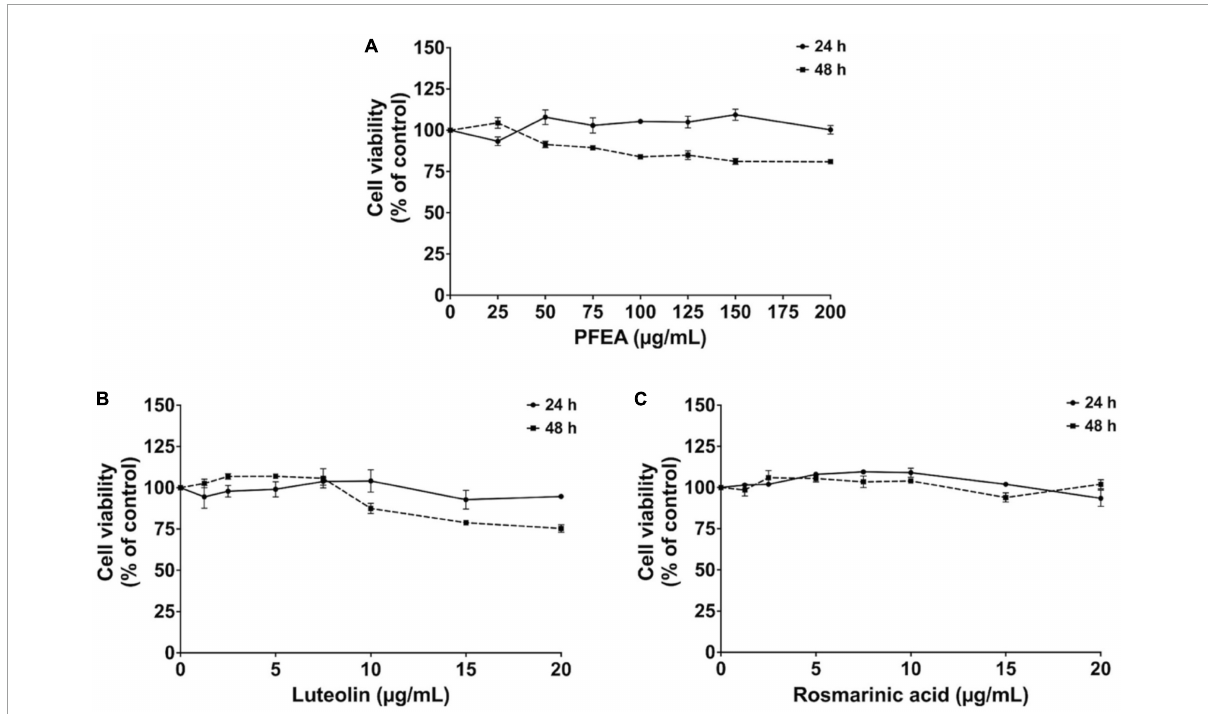
FIGURE1 Cytotoxicity of PFEA and its active compounds on A549 cells. The cells were treated with PFEA (A) , luteolin (B) , and rosmarinic acid (C) for 24 and 48 h. Cell survival was determined using the MTT assay. Data are presented as mean ± S.D. values of three independent experiments. Data are presented as mean ± S.D. values of three independent